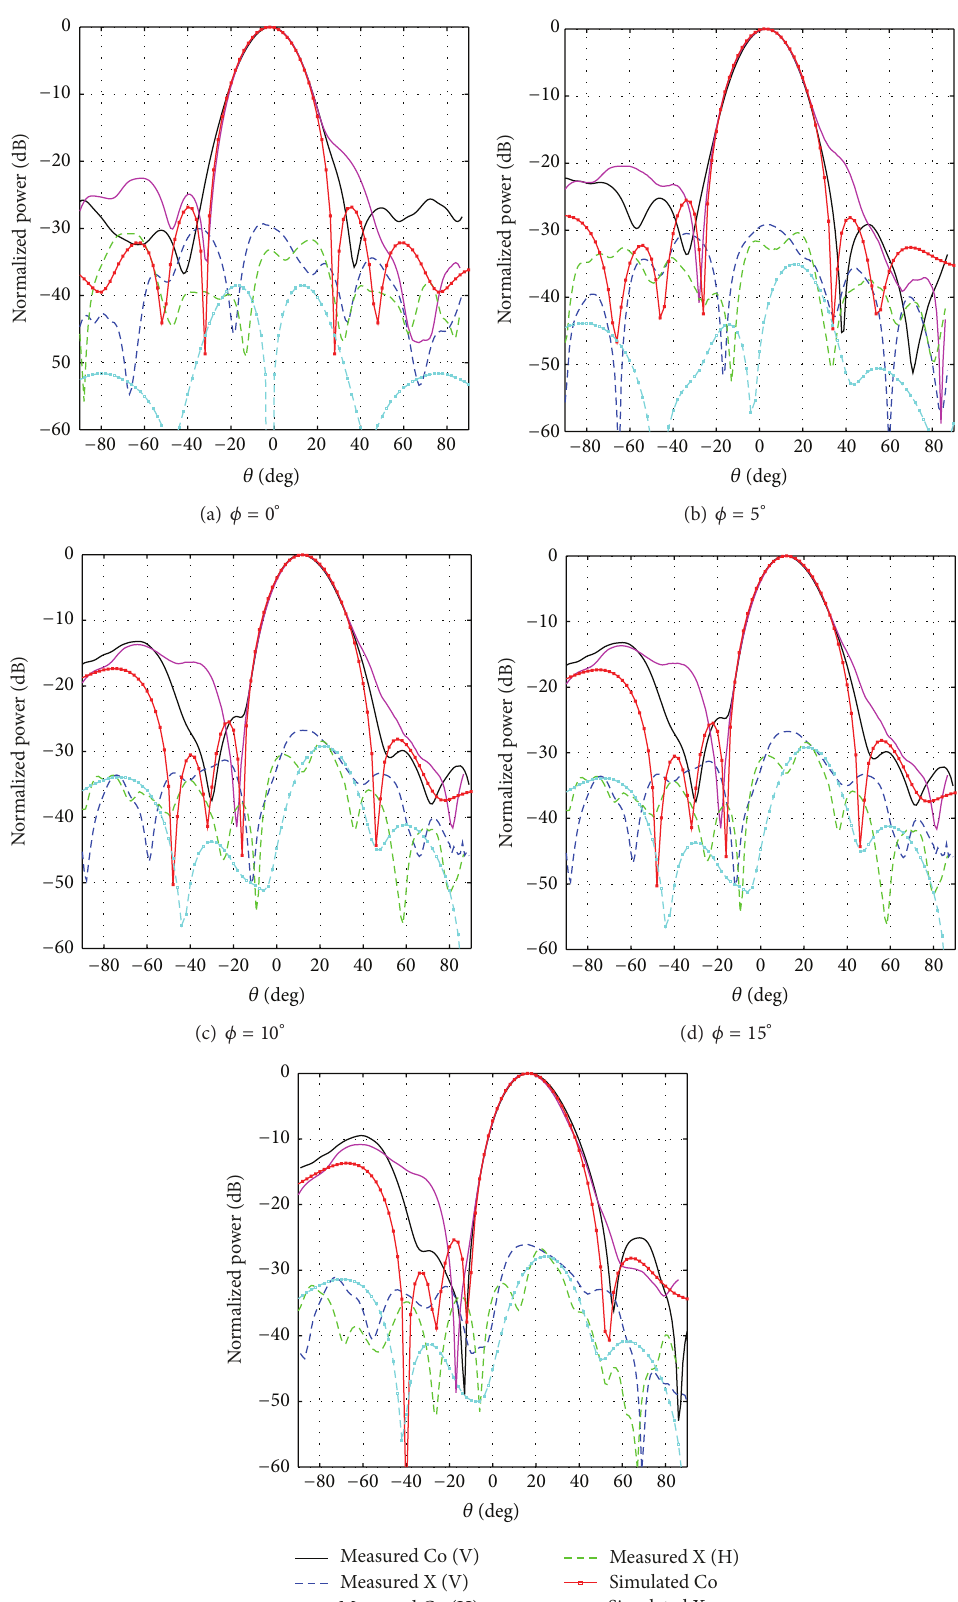
Figure 10: Measured polarimetric array patterns with actual amplitude tapering. Beam-steering angle 𝜙 is in azimuth direction. Simulations are performed using